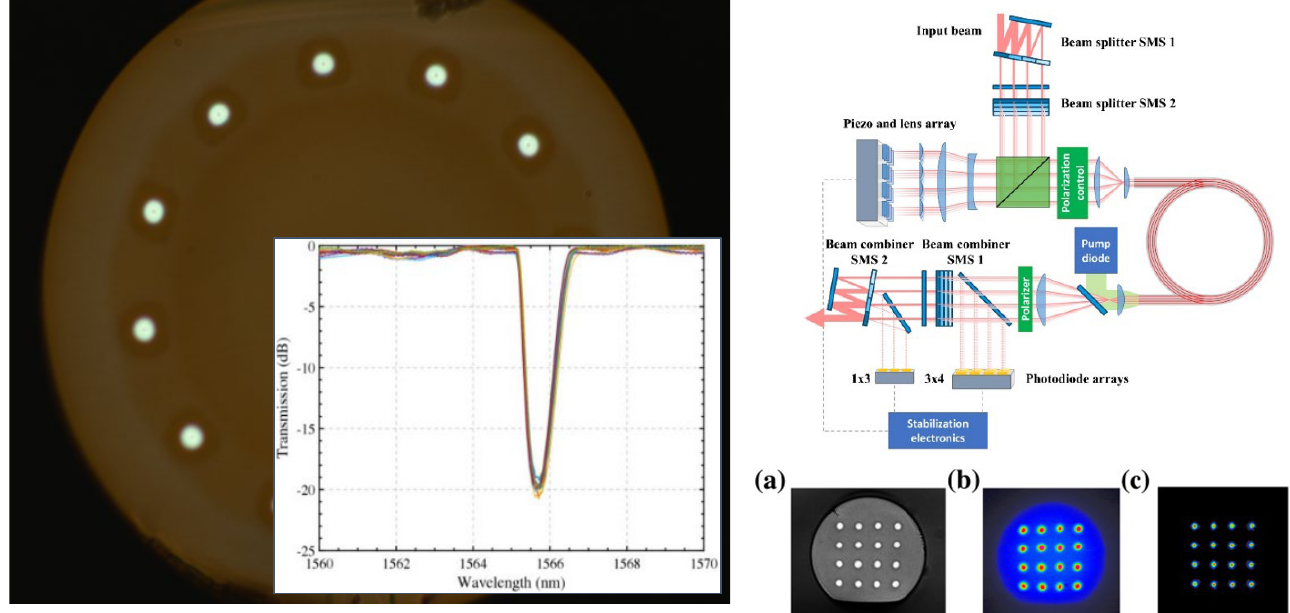
Fig. 1: Multi-Core fiber for sensing applications. Fig. 2: Coherent combination of